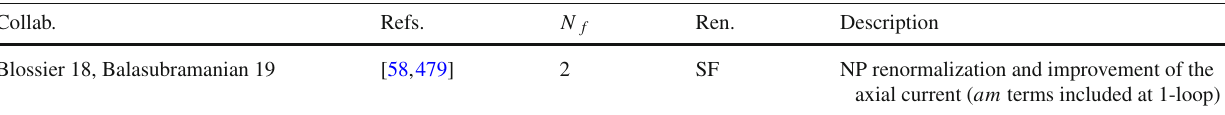
Table 132 Operator renormalization in N f = 2 determinations of the D - and D s -meson decay constants Collab.